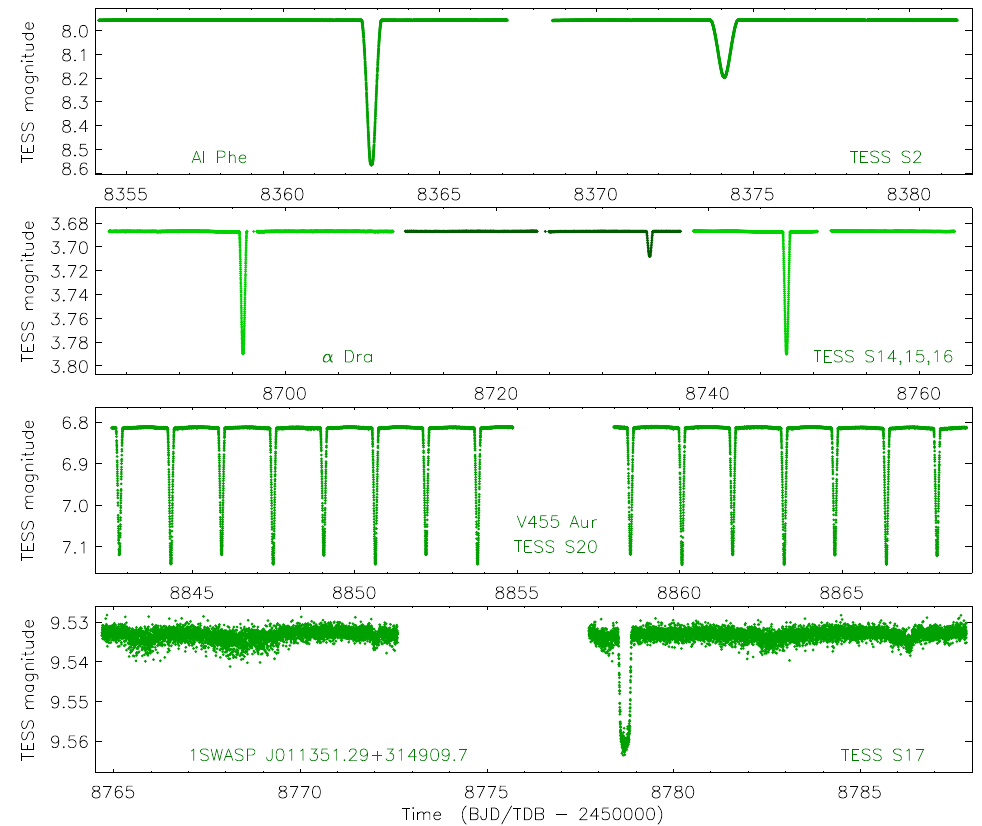
Figure 7. Example TESS light curves of binary systems. The names and sectors are labelled. The data for α Dra have been binned to decrease the size of the image